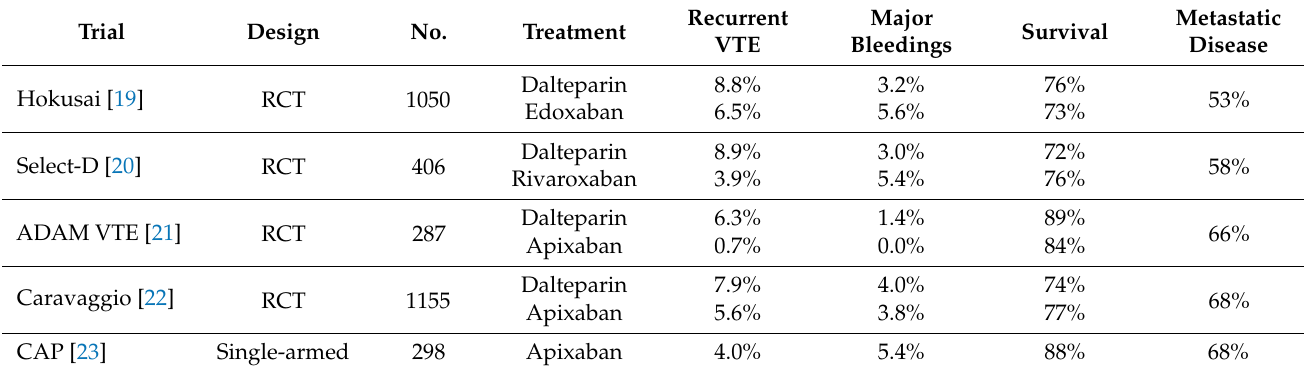
Table 3. Interventional studies on cancer-associated VTE treated with direct-acting oral anticoagulants or low-molecular- weight heparin. Trial